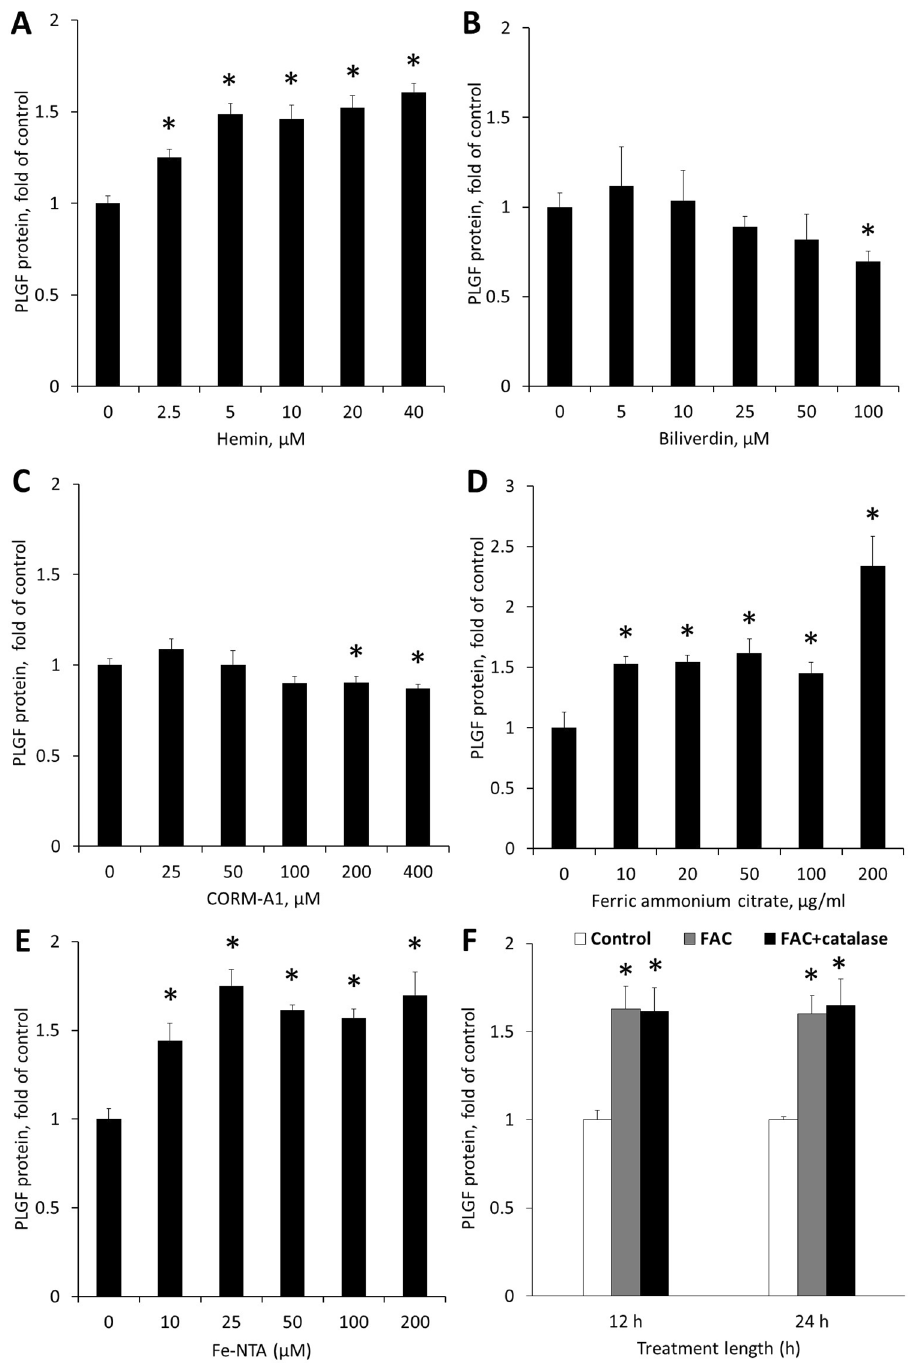
Figure 3. HO-1 activity increases secreted PLGF. Co-cultures were treated with the compounds shown for 24 h. ( A ) Hemin, an inducer of HO-1 activity, significantly increased secreted PLGF at all concentrations used (n = 5, p < 0.05). ( B ) Biliverdin, a product of HO-1, significantly decreased secreted PLGF at 100 µM (n = 5, p < 0.05). ( C ) CORM-A1, a carbon monoxide releasing molecule, slightly but significantly decreased secreted PLGF at 200 µM and 400 µM (n = 5, p < 0.05). ( D ) Ferric ammonium citrate (FAC) significantly increased secreted PLGF at all concentrations (n = 5, p < 0.05). ( E ) Iron nitrilotriacetic acid (iron-NTA) similarly increased PLGF